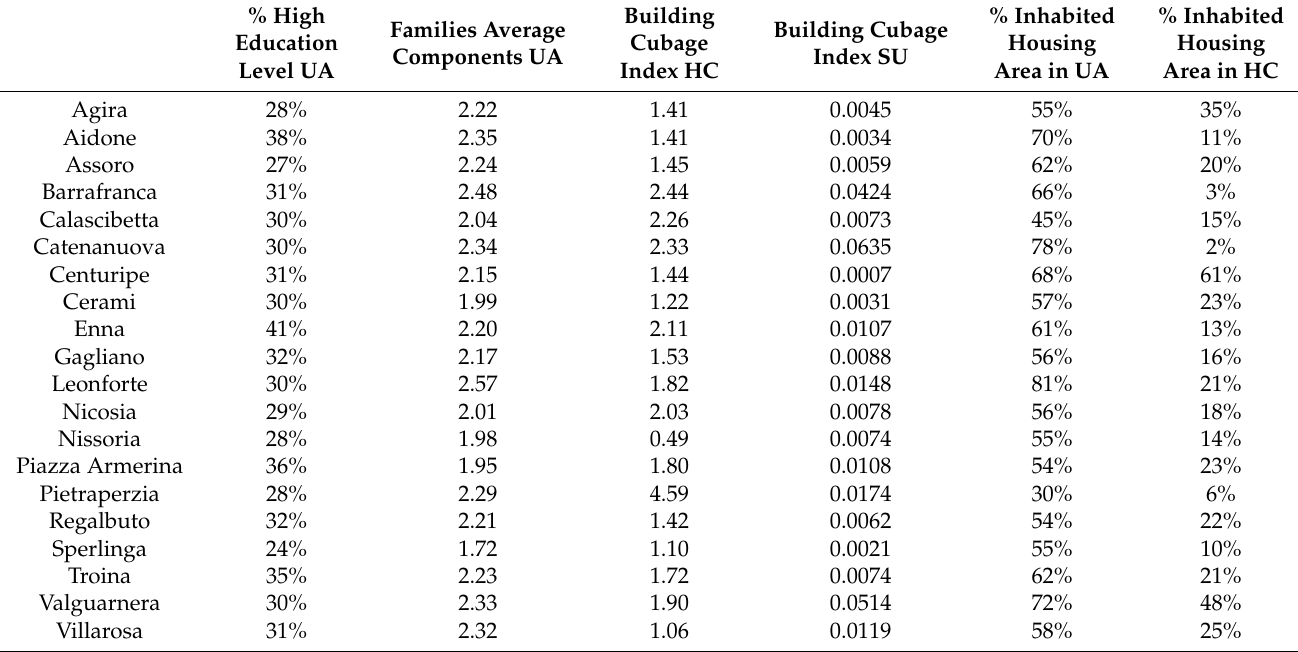
Table 5. Data and indices showing the distribution of the UA (Urban Area) population between SU (SUburbs) and HC (Historic